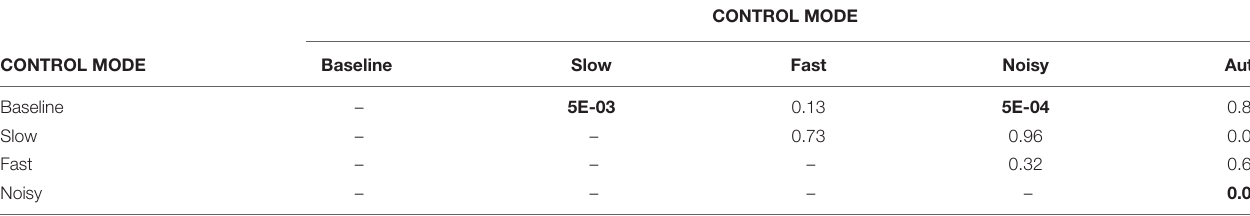
TABLE 3C | Post hoc comparisons ( p -values) for implicit agency across control modes on compliant surface.